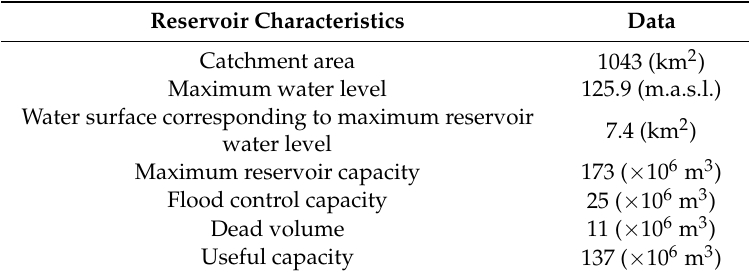
Table 1. Characteristic data of the Guardialfiera